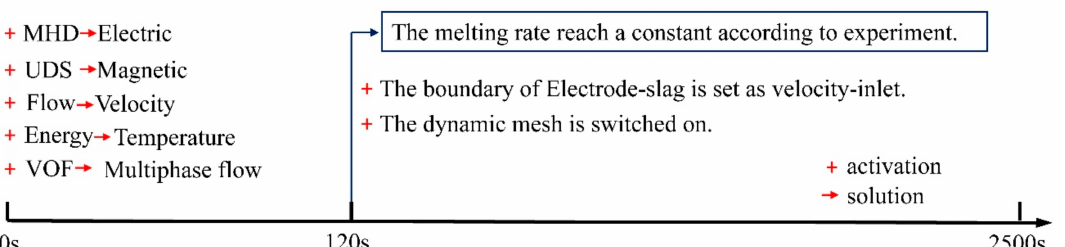
Figure 3. Schematic diagram of the calculation process.